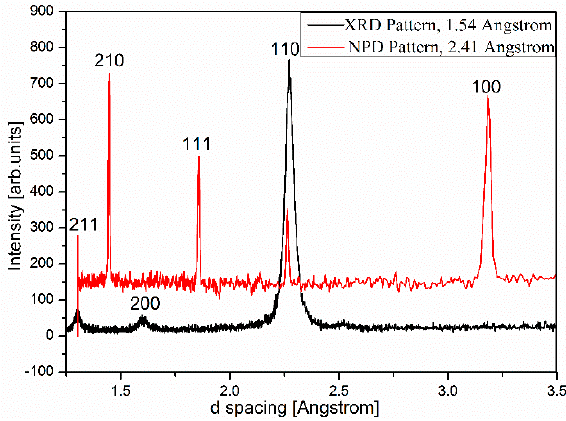
Figure 2. XRD and neutron powder diffraction (NPD) (measured with WOMBAT diffractometer) patterns of the Ti-16Al-27Nb-0.6Er alloy.